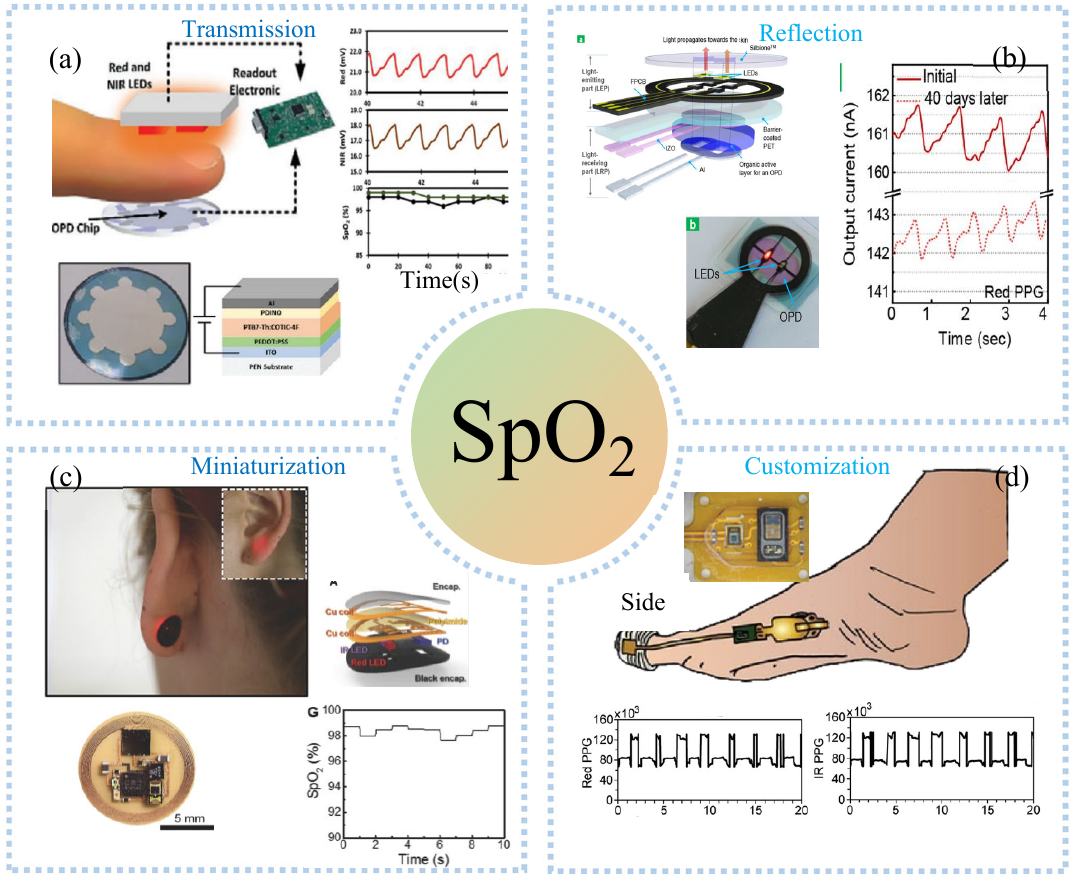
Figure 9. Blood detection: ( a ) transmissive PPG sensor at the fingertip and provides reliable blood oxygen monitoring. Reprinted with permission from Refs. [99]. Copyright 2022 John Wiley and Sons, ( b ) reflective PPG sensor at the fingertip and provides reliable blood oxygen monitoring. Reprinted with permission from Refs. [119]. Copyright 2021 American Chemical Society, ( c ) miniaturized PPG sensor monitoring blood oxygen in the earlobe. Reprinted with permission from Refs. [120]. Copyright 2016 John Wiley and Sons, ( d ) customized PPG sensors at the toes and provide reliable blood oxygen monitoring while walking. Reprinted with permission from Refs. [121]. Copyright 2020 John Wiley and Sons.